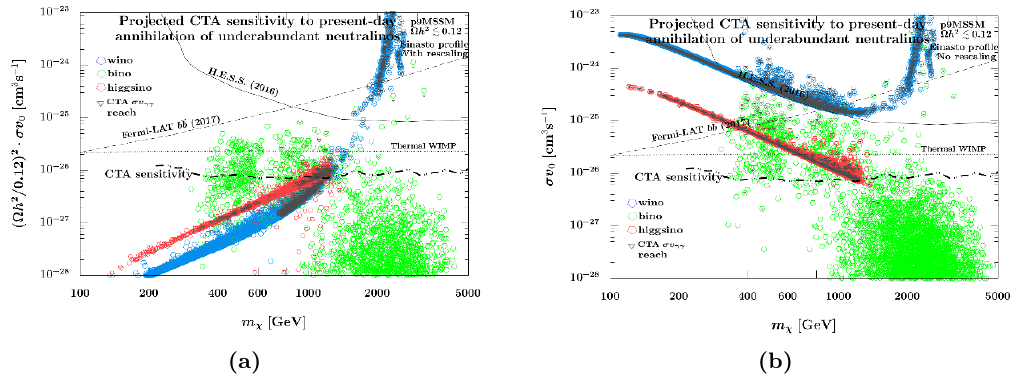
(cid:27)v 0 ) plane for 5 : 99 in ( m (cid:31) , ((cid:10) (cid:31) h 2 = 0 : 12) 2 (cid:20) (cid:1)